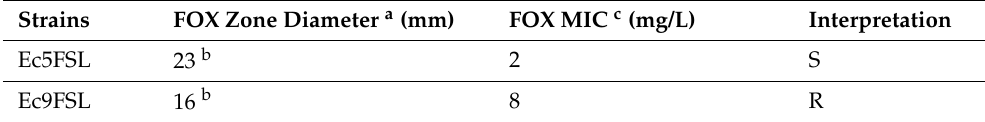
Table 1. FOX susceptibility tests against the Ec5FSL and Ec9FSL isolates. Strains FOX Zone Diameter a (mm) FOX MIC c (mg/L) Interpretation Ec5FSL 23 b